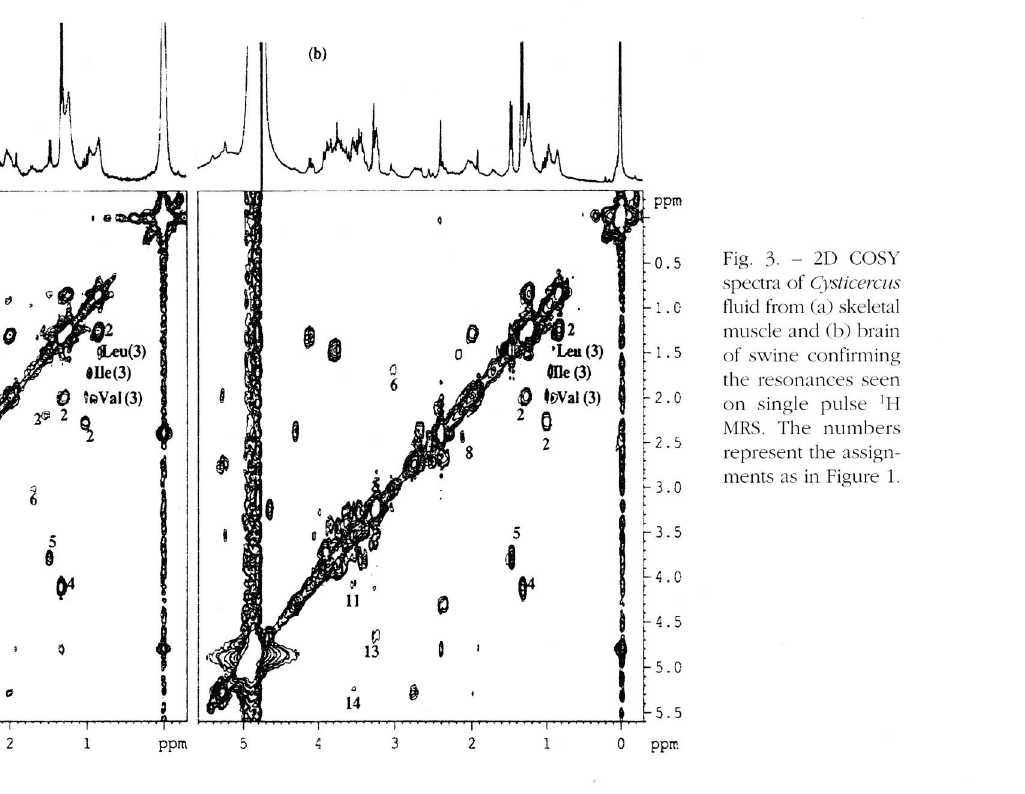
Fig. 3. - 2D COSY spectra of Cysticercus fluid from (a) skeletal muscle and (b) brain of swine confirming the resonances seen on single pulse 1 H MRS. The numbers represent the assign ments as in Figure 1.